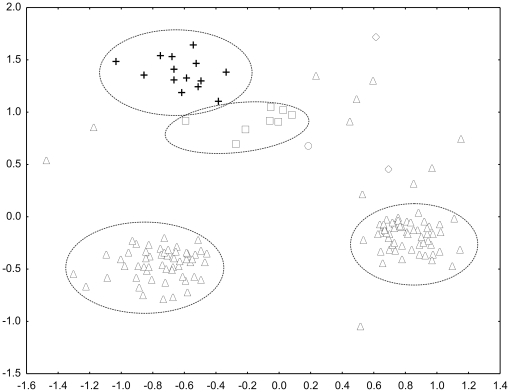
Plots of the values of the first and second principal coordinates obtained from pairwise genetic distances at 8 microsatellite loci among all F1 stocks (Treviso, Piacenza, Orzinuovi) plotted according to mtDNA haplotype: haplotype 2 (triangles), halotype 3 (crosses), haplotype 4 (squares), haplotype 5 (diamonds), haplotype 6 (circles).Stress value =  0.14.